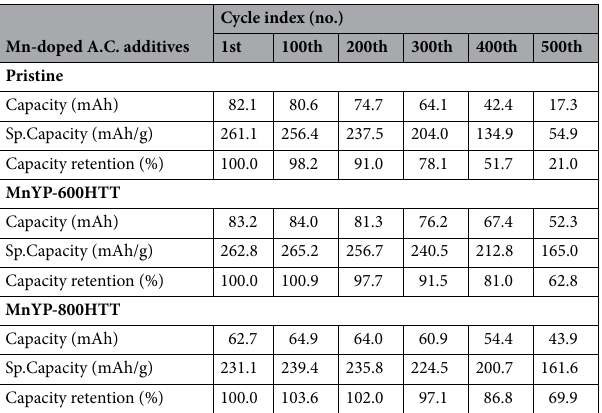
Table 3. Cycling test result of Pristine, Mn-doped MnYP-600HTT and MnYP-800HTT under 500 cycles.